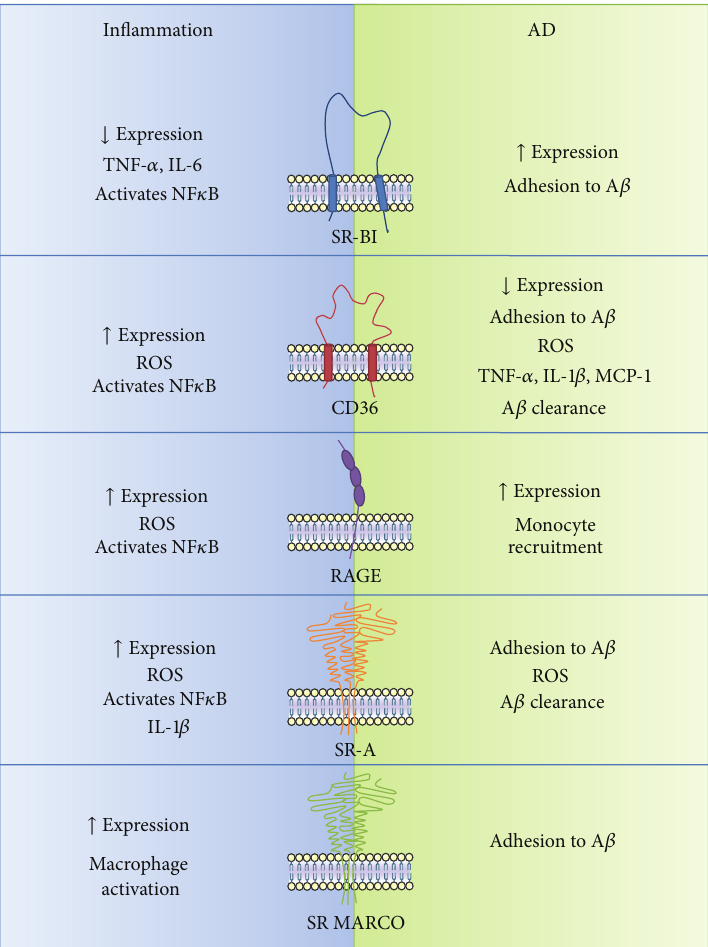
Figure 1: Summary of the main characteristics and functions played by SRs in inflammation and AD. The left panel shows changes induced by the inflammatory activation of SRs reviewed in the text. The right panel resumes the principal alterations induced by the activation of SRs mediated by the amyloid